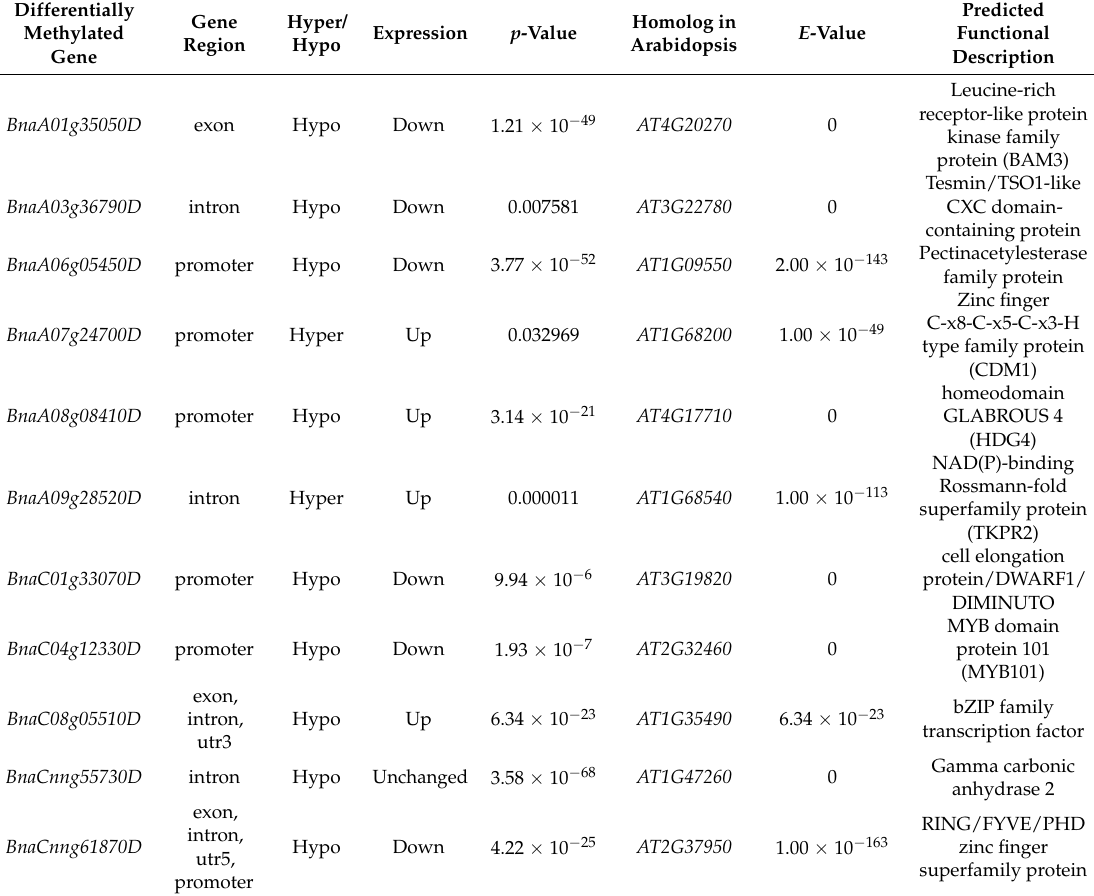
Table 2. Information of eleven DMR-associated genes involved in pollen